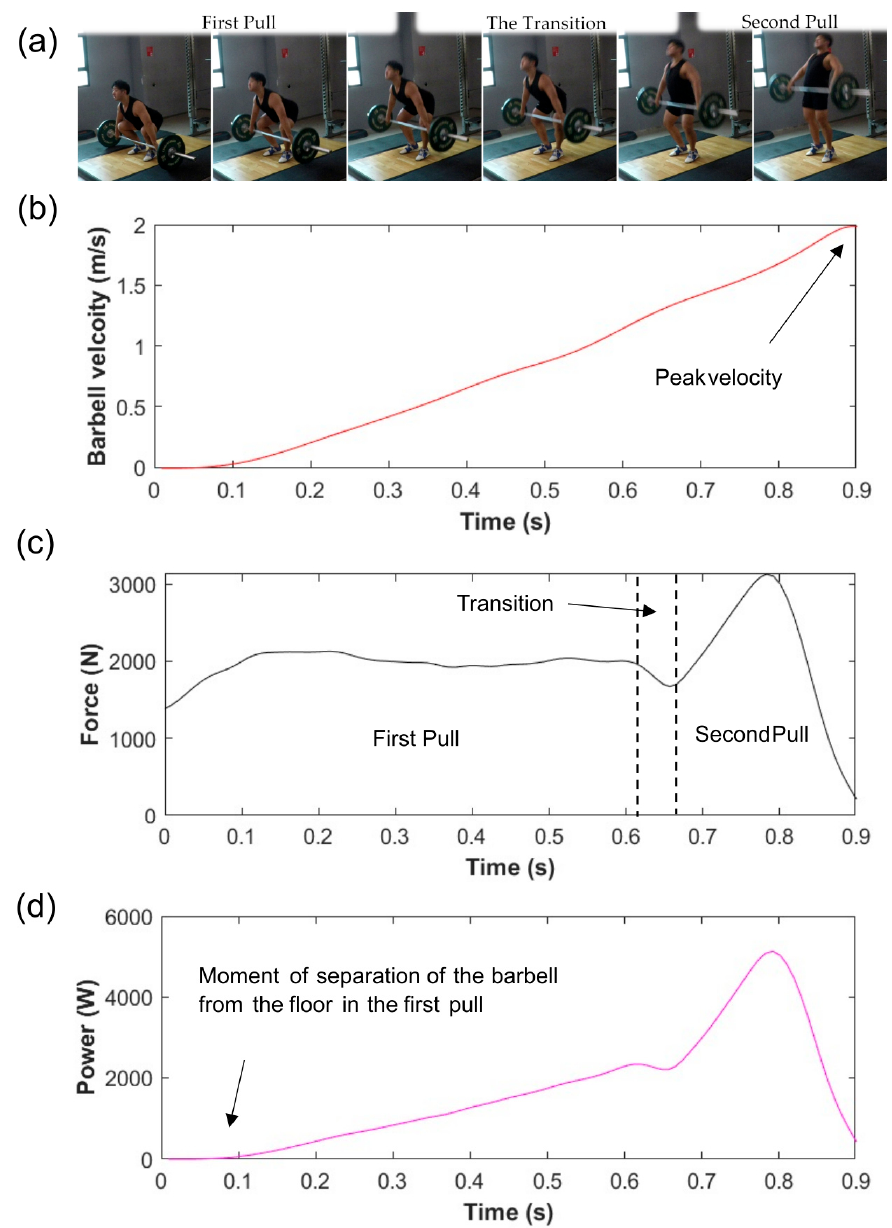
Figure 2. ( a ) Representative pictures of the three snatch phases and associated ( b ) velocity–, ( c ) force–, and ( d ) power–time graphs from the moment of separation of the barbell in the first pull to the moment at which peak velocity occurred in the second pull of the